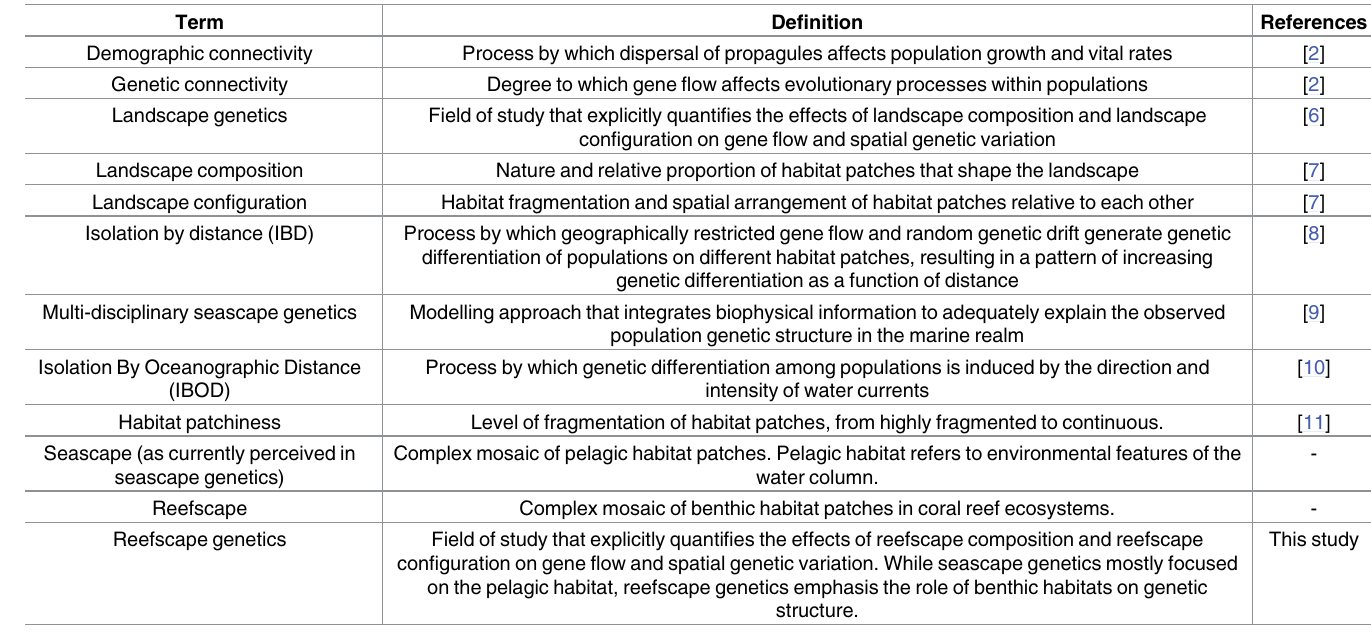
Table 1. Definitions for the main technical terms used in this study, with references.